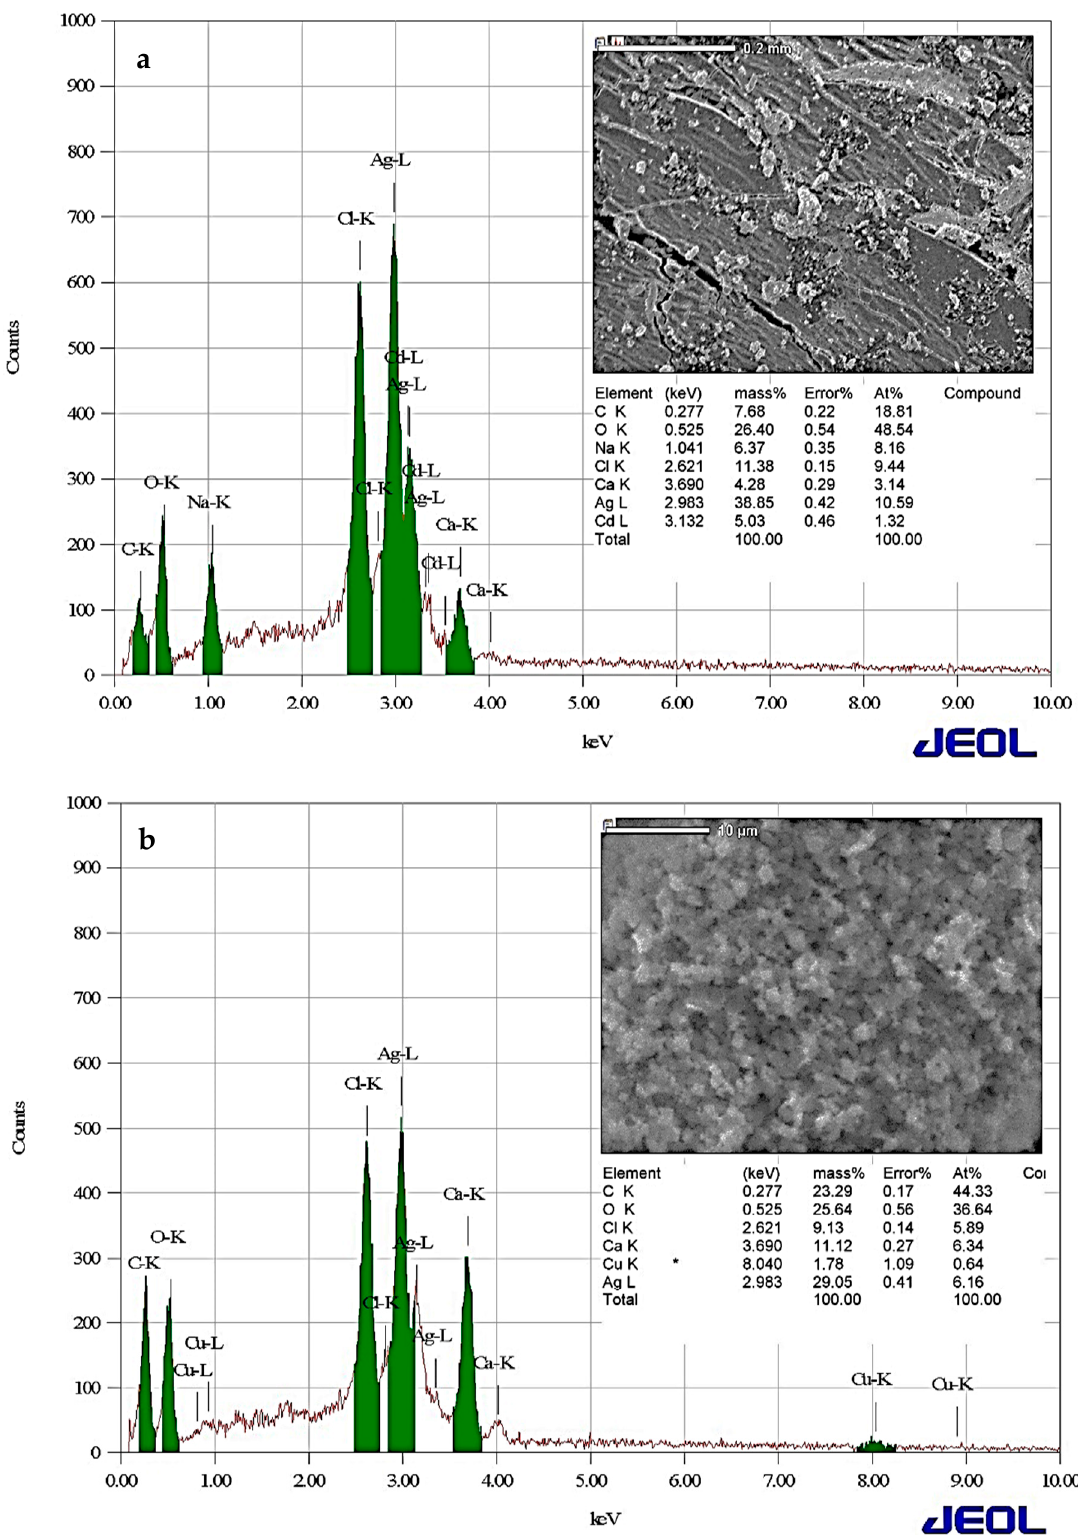
Figure 4. Energy-dispersive X-ray spectroscopy (EDS) images of AgNPs (0.2 g) before ( a ) and after Cu 2+ (10 mg/L) was adsorbed ( b ) for 3 h at 298 K.